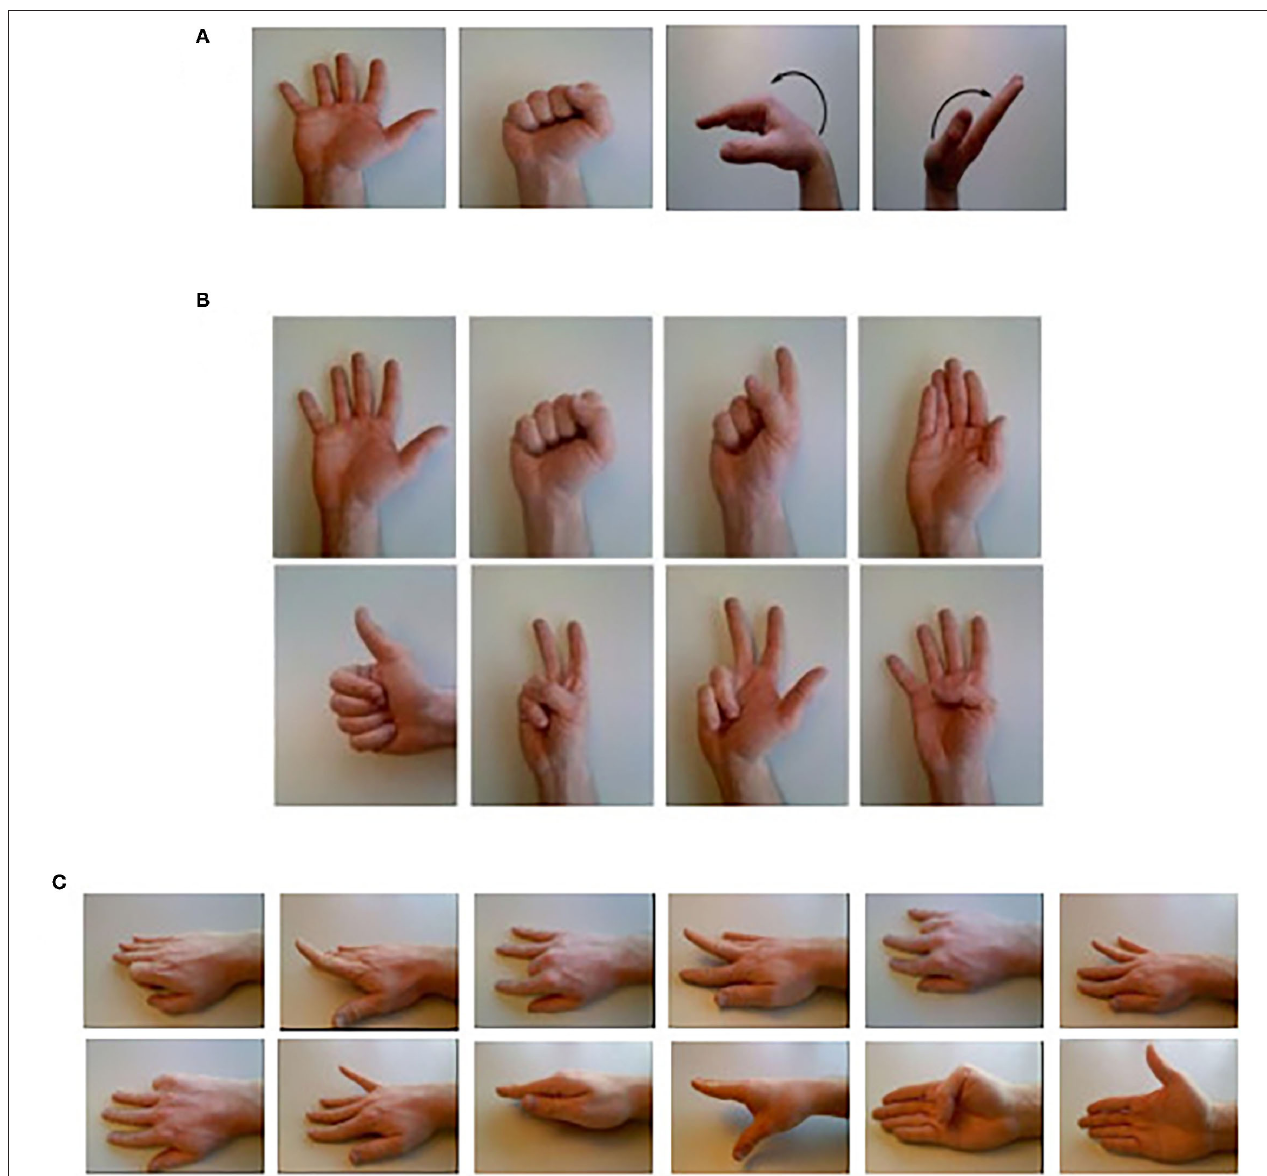
FIGURE 2 | Twenty-two daily gesture: (A) four basic movements of the wrist and hand (Group one), (B) eight isometric, isotonic hand configurations (Group two), and (C) 12 basic movements of the fingers (Group three) (Atzori et al.,